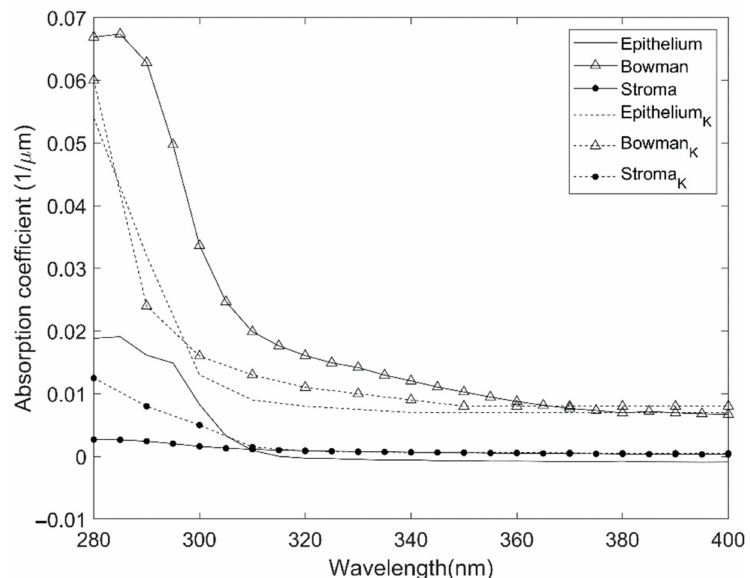
Figure 5. Comparison of our absorption coefficient results for epithelium, Bowman’s, and stroma with those obtained from Kolosv á ri et al. [17] epithelium k , Bowman k and stroma k